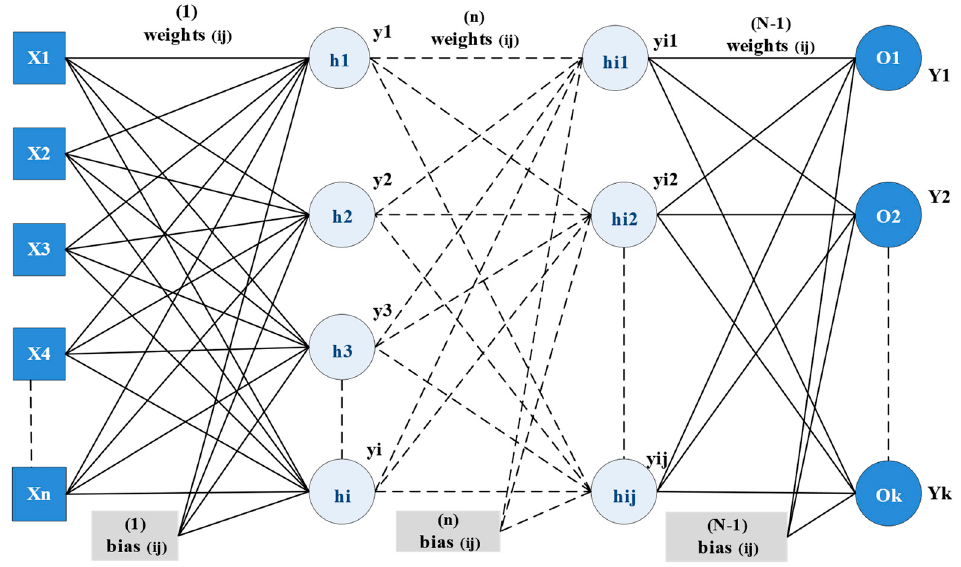
Figure 3. General model of multilayer neural network structure.